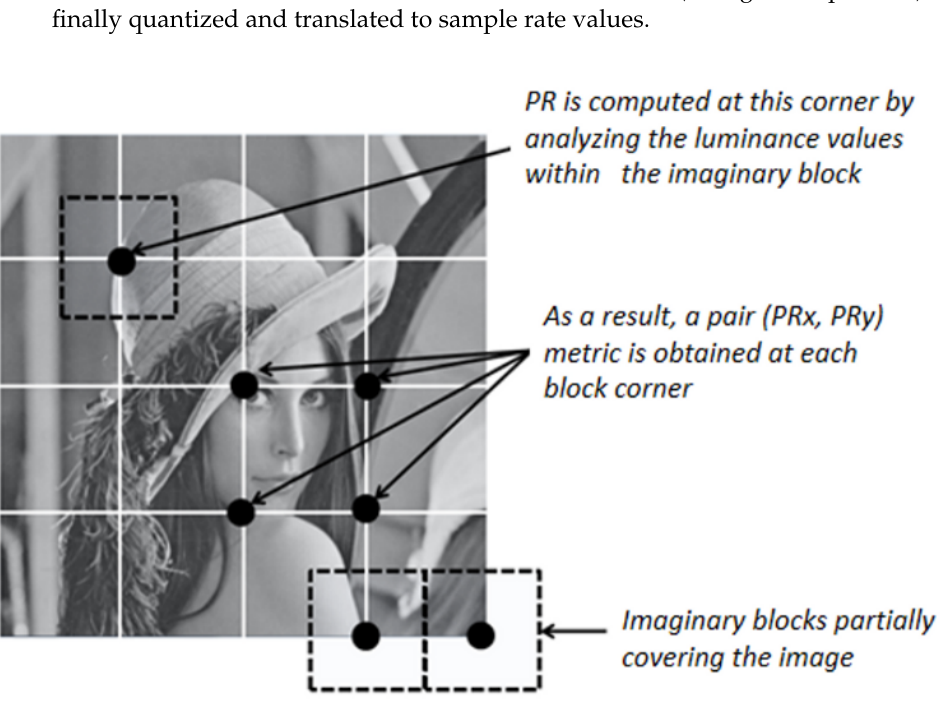
Figure 3. Imaginary blocks and PR metric